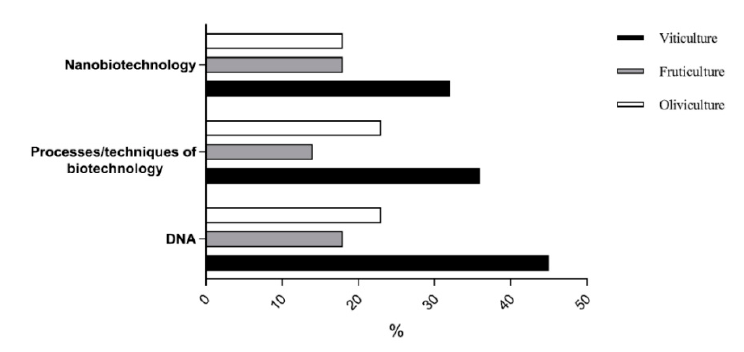
Figure 4. Biotechnology activities developed by the business per activity sector in the last five years. Source: Author’s calculation from the research dataset.